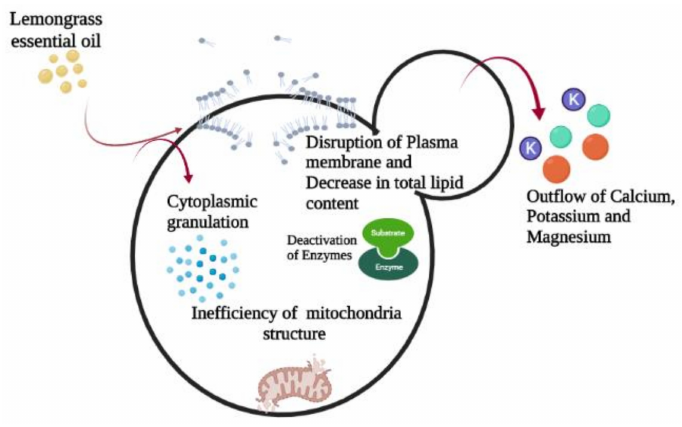
Figure 3. Effect of lemongrass essential oil on a fungal